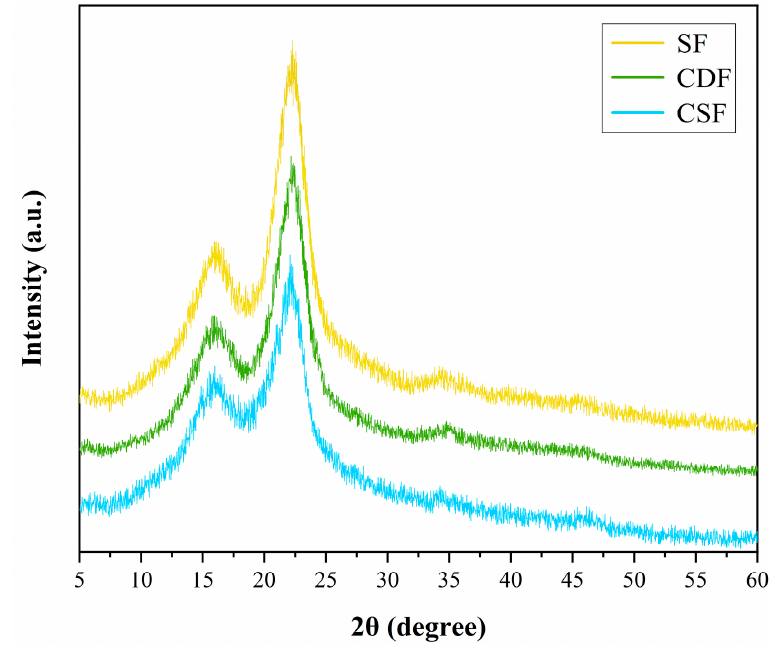
Figure 3. XRD patterns of the fiber samples CDF, CSF, and SF. Table 2. Crystallinity characteristics of the fiber samples CDF, CSF, and SF. Fiber